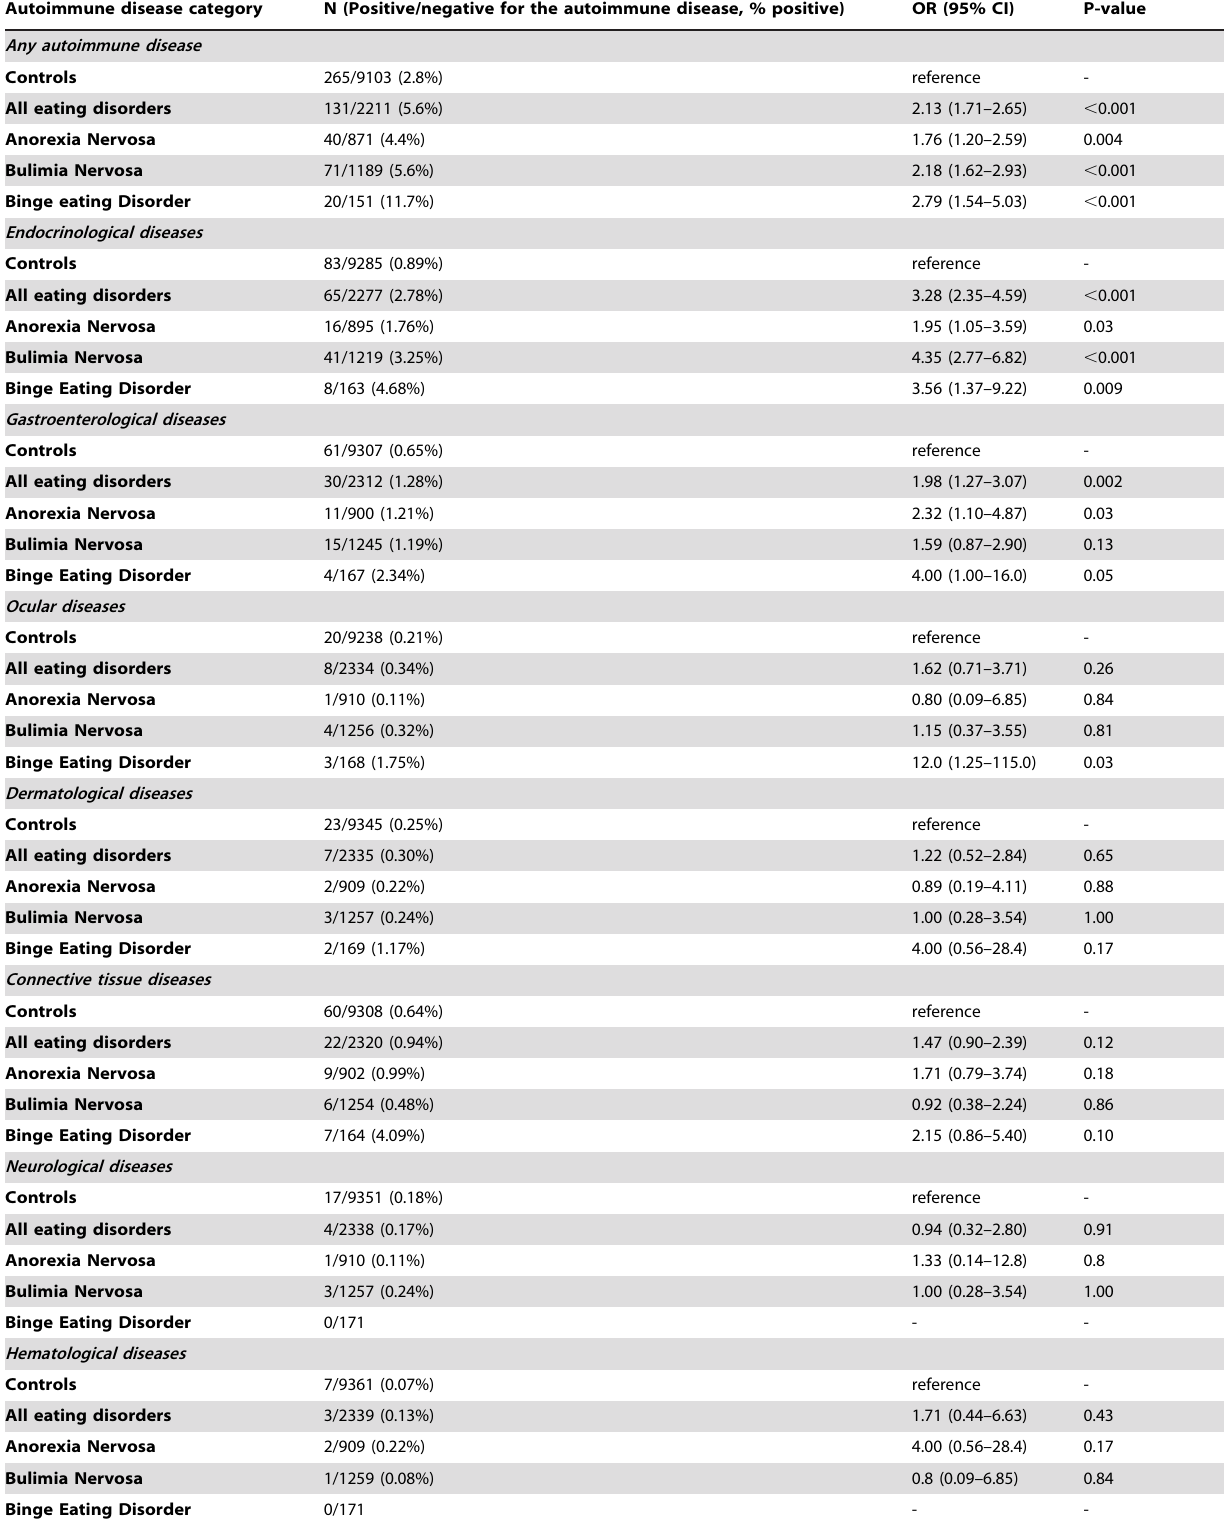
Table 2. Period prevalences and results from conditional logistic regression models of autoimmune diseases from the start of the study period until the beginning of the treatment of an eating